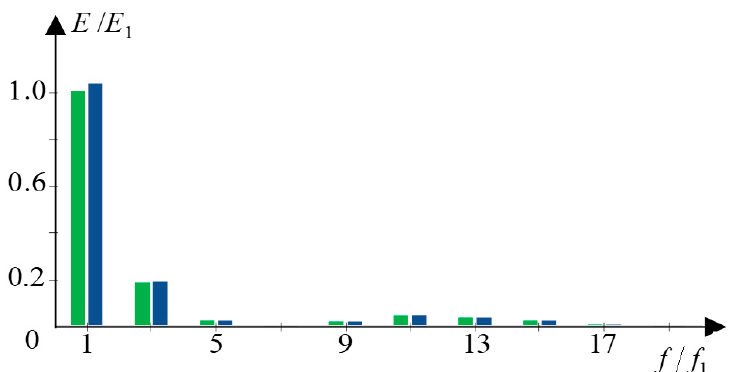
Figure 9. No ‐ load voltage induced in a stator phase at 1500 rpm. ( a ) Time behavior; ( b ) amplitude frequency spectrum in p.u. Theoretical (brown line) and FEM values (blue line).